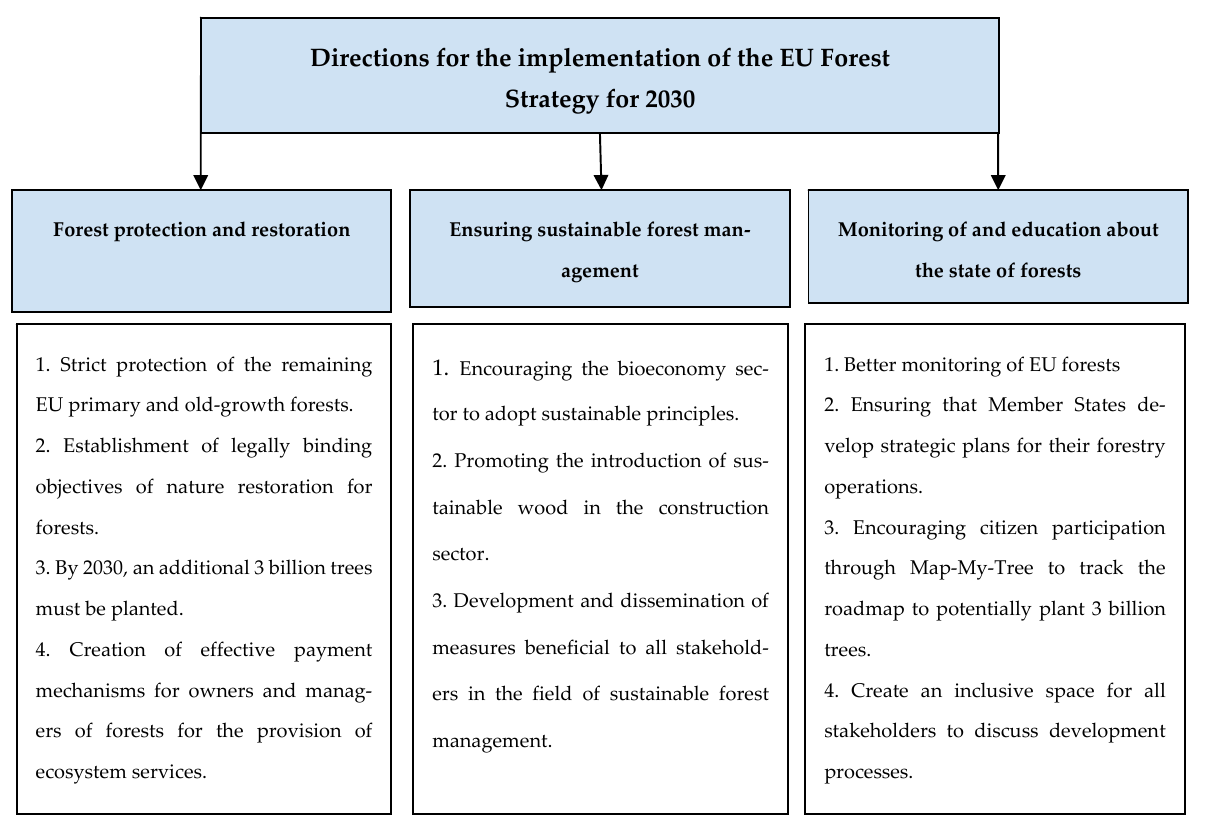
Figure 2. Directions for the implementation of the EU Forest Strategy for 2030. Scheme 2021 .